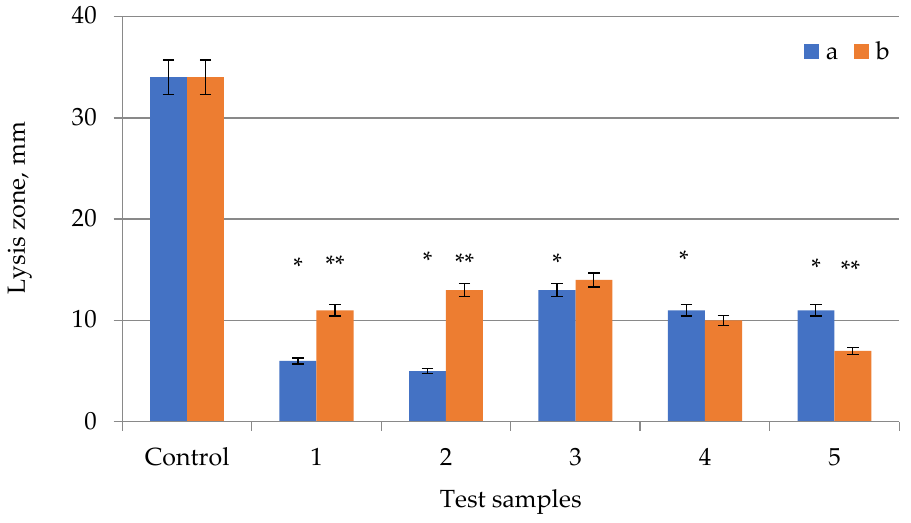
Figure 3. Testing the antimicrobial effect against Pseudomonas aeruginosa of Eucalyptus globulus extracts of different extraction times (a) with US treatment and (b) without US treatment: 1 — 10 min; 2 — 15 min; 3 — 20 min; 4 — 25 min; 5 — 30 min. Control — ampicillin (2.5 µg/10 µL). Values of the treated and control cultures followed by the symbol “*” do differ significantly ( p < 0.05) as assessed